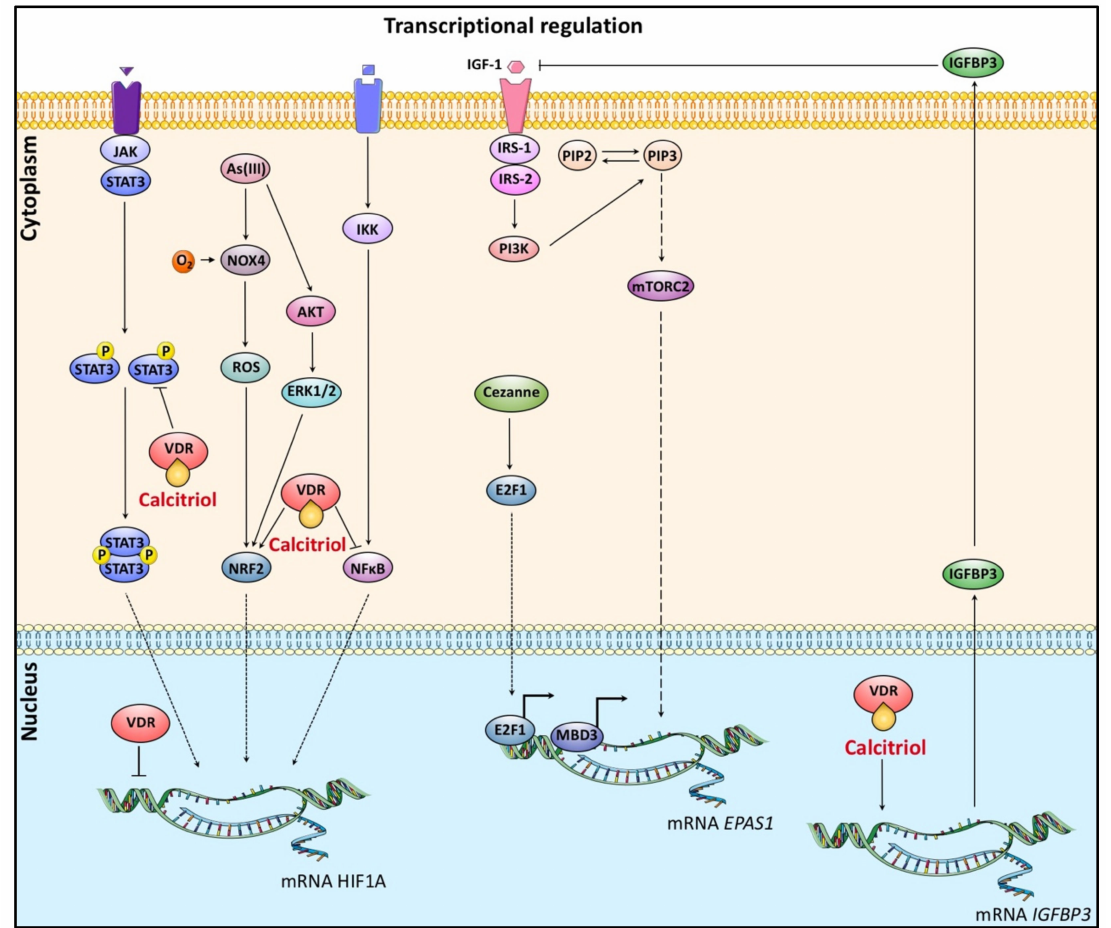
Figure 2. The implication of calcitriol signaling in the transcriptional regulation of HIF1A and EPAS1 genes. Calcitriol binding to VDR results in the expression of proteins that control the activity of STAT3-, NRF2-, NF- κ B-dependent pathways, and interferes with HIF1A transcription. There are also data suggesting that VDR directly inhibits HIF1A expression, albeit in the absence of calcitriol. Moreover, the calcitriol-VDR complex indirectly controls EPAS1 transcription by enhancing the expression of IGFBP3